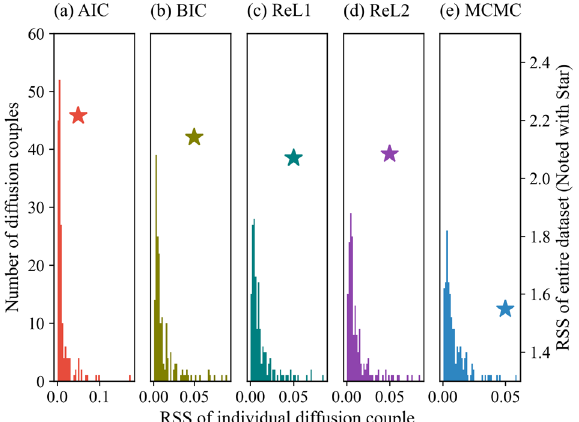
Fig. 7 Goodness-of- fi t statistics for the proposed algorithms. The histograms are counts of diffusion couples with different intervals of mean square error concerning optimization algorithms, i.e., a variable-selection genetic algorithm based on AIC, b variable- selection genetic algorithm based on BIC, c L1 norm regularization, d L2 norm regularization, and e Markov chain Monte Carlo, while the marker “ star ” denotes RSS due to the entire